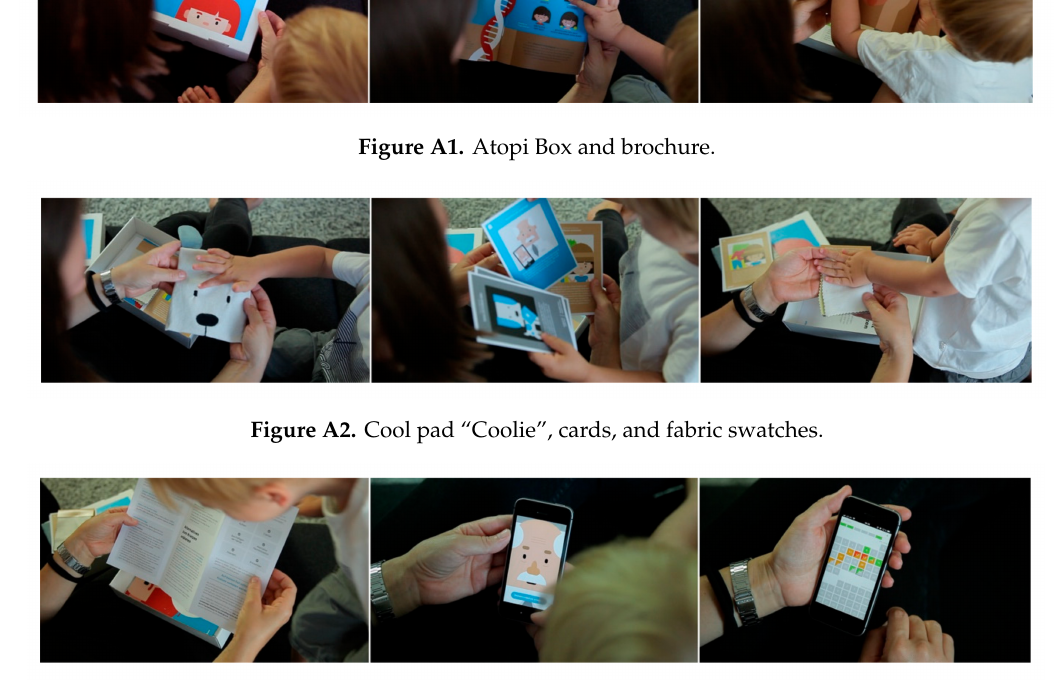
Figure A3. Folder, Dr. Atopi in atopi app, severity-scoring in app.